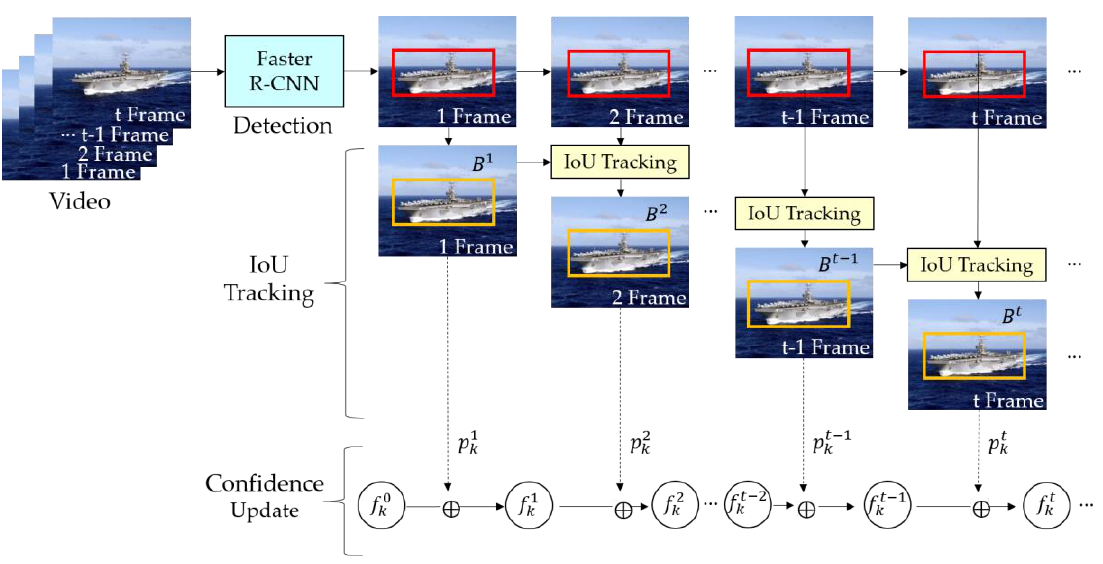
Figure 5. Robust single ship detection system based on video in our proposed algorithm.